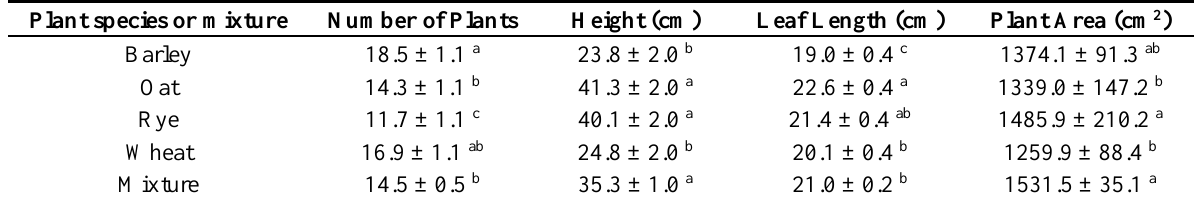
Table 3. Mean (± SEM) plants surviving, plant height, leaf length, and plant area of plant species and mixtures. Means followed by different letters within a column are significantly different using Tukey’s HSD after a significant main effect of plant species in repeated measures ANOVA (Table 2).